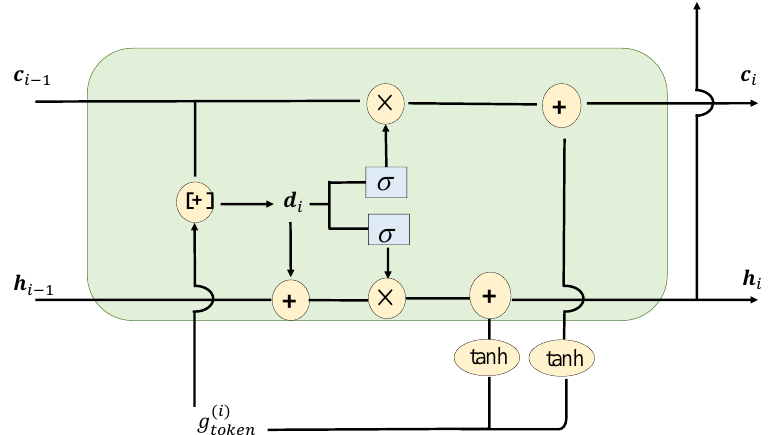
Figure 6. The structure of the